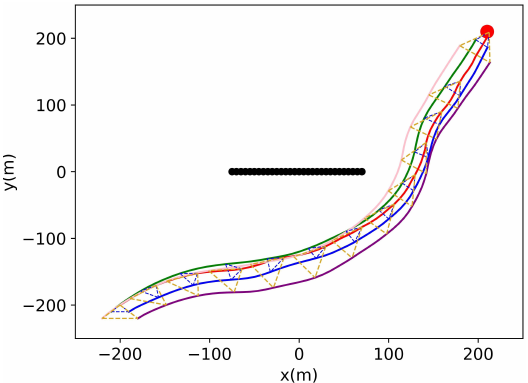
Figure 17. Trajectory of UGV double-layer triangle formation.